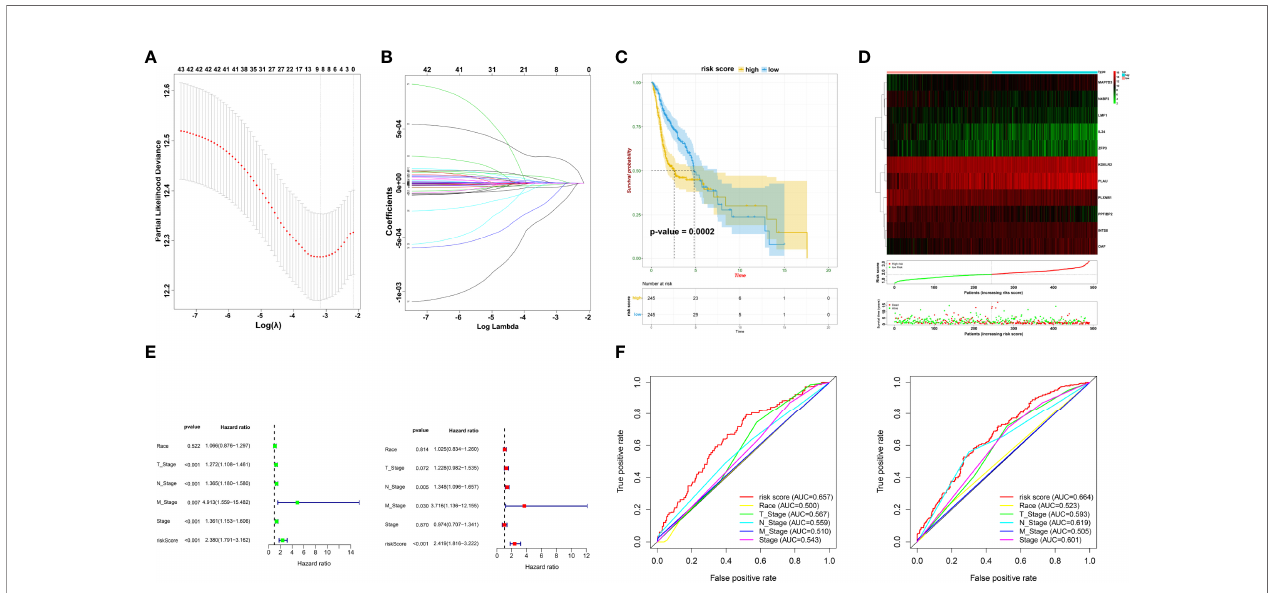
FIGURE 3 | Prognostic signature construction. (A, B) Screening of candidate crucial genes from the LASSO Cox regression. (C) The Kaplan – Meier plot of high- and low-risk groups. (D) Distributions of risk scores, alive/dead status, and expression of crucial prognostic genes. (E) Univariate (left) and multivariate Cox analyses (right) of clinical traits. (F) ROC curve of risk score and clinical traits in 1 and 3 years.